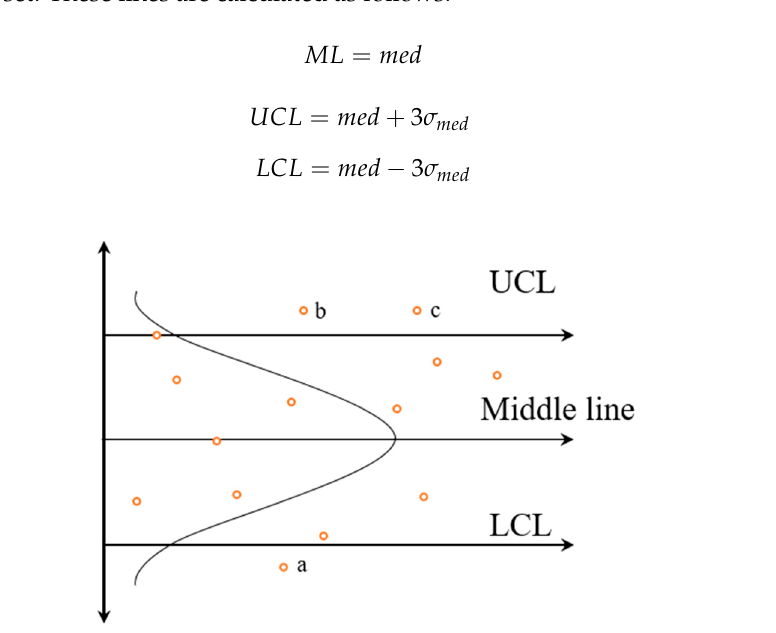
Figure 1. Points a, b, and c are anomaly data with a 0.3% of chance, since they are not in the interval.